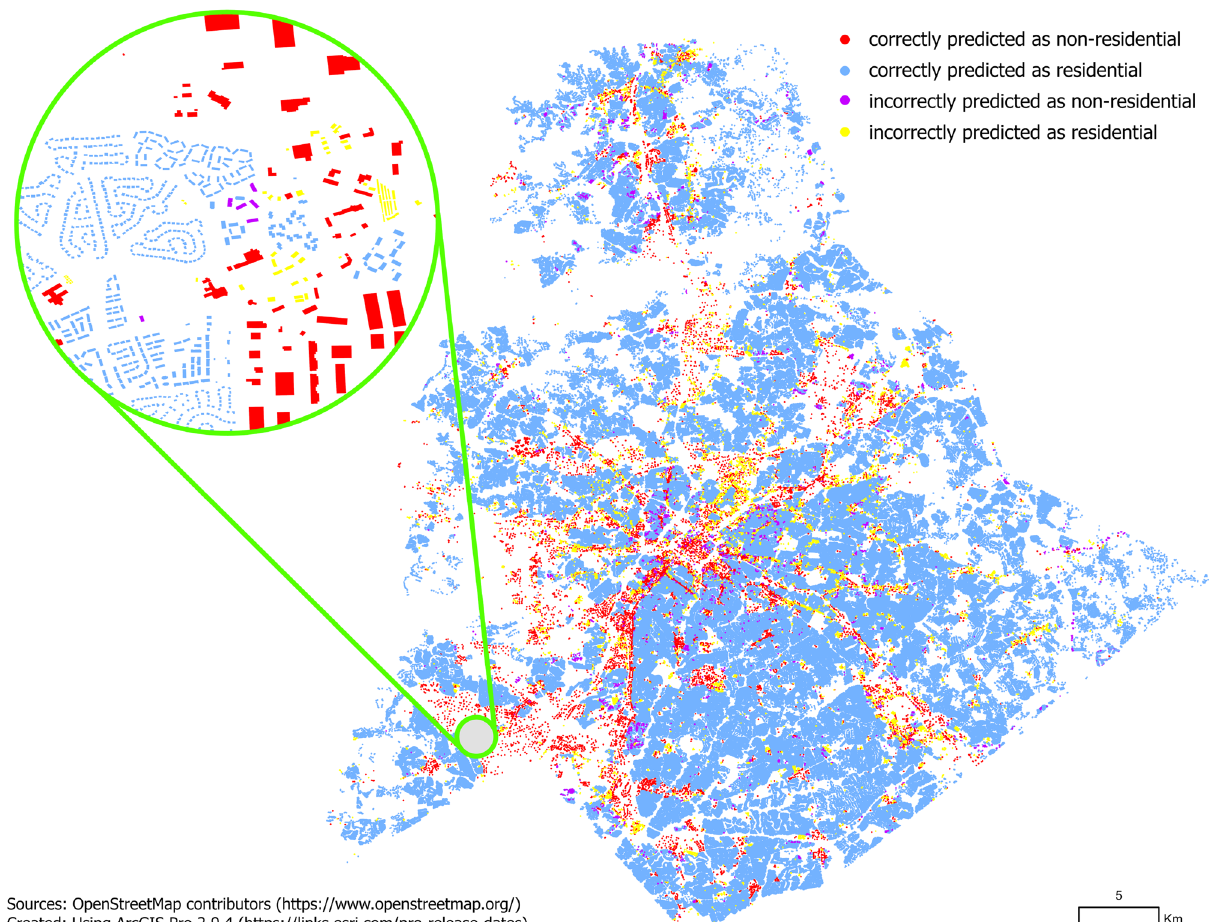
Figure 4. Residential and non-residential building type based on transfer learning model for Fairfax County transferred to Mecklenburg